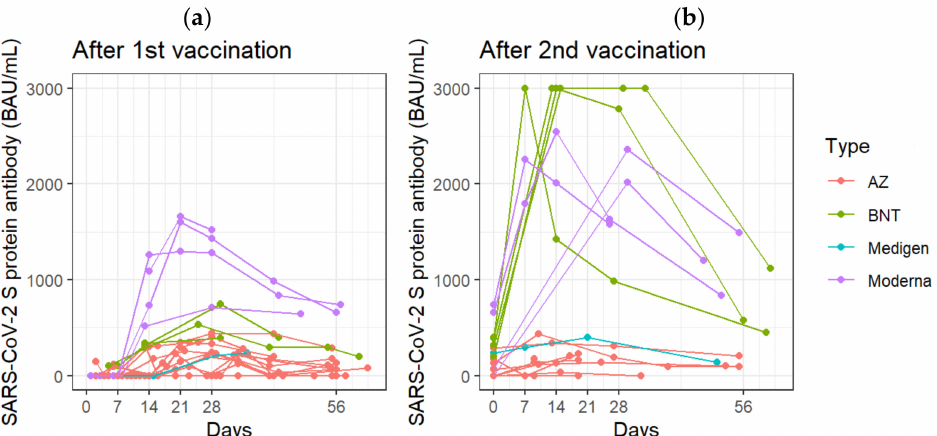
Figure 8. Follow-up measurements of anti-SARS-CoV-2 S protein total antibodies ( a ) at the indicated days after the first vaccination ( b ) at the indicated days after the second vaccination. Each line represents the concentration of antibodies in the blood continuously measured after receiving one brand of vaccine on the specified